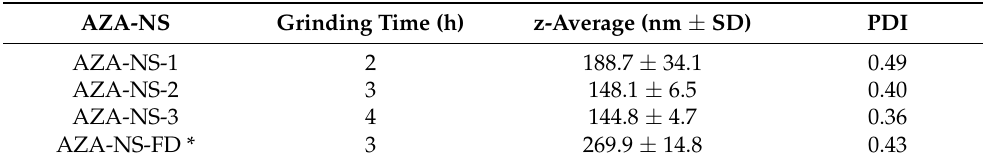
Table 1. The z-average particle size and polydispersity index (PDI) of azelaic acid nanosuspensions